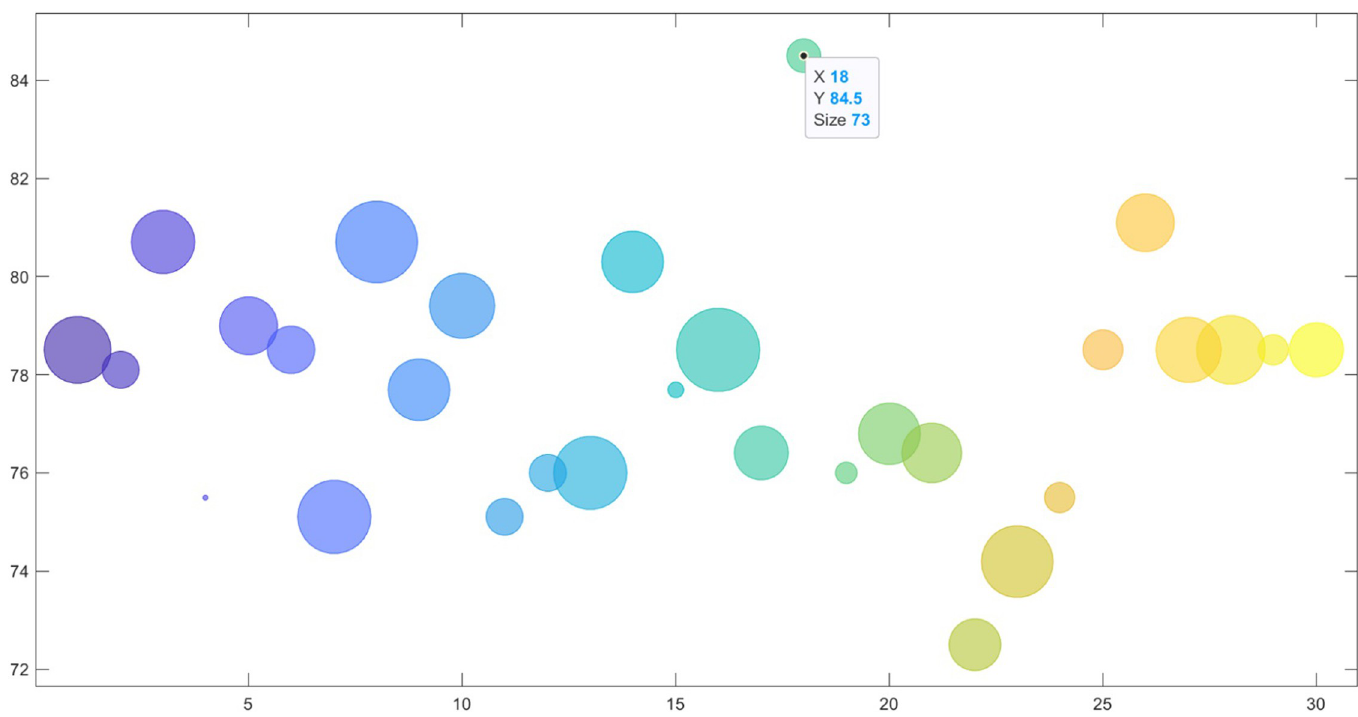
Fig 4. Accuracy (%) of PGSA during thirty independent runs. The Y and X axes imply the accuracy and iteration respectively. The bubble size is correlated with the number of genes; the bigger the bubble, the higher the number of genes. The best model was reached at the 18 th run with 84.5% accuracy and 73 genes.